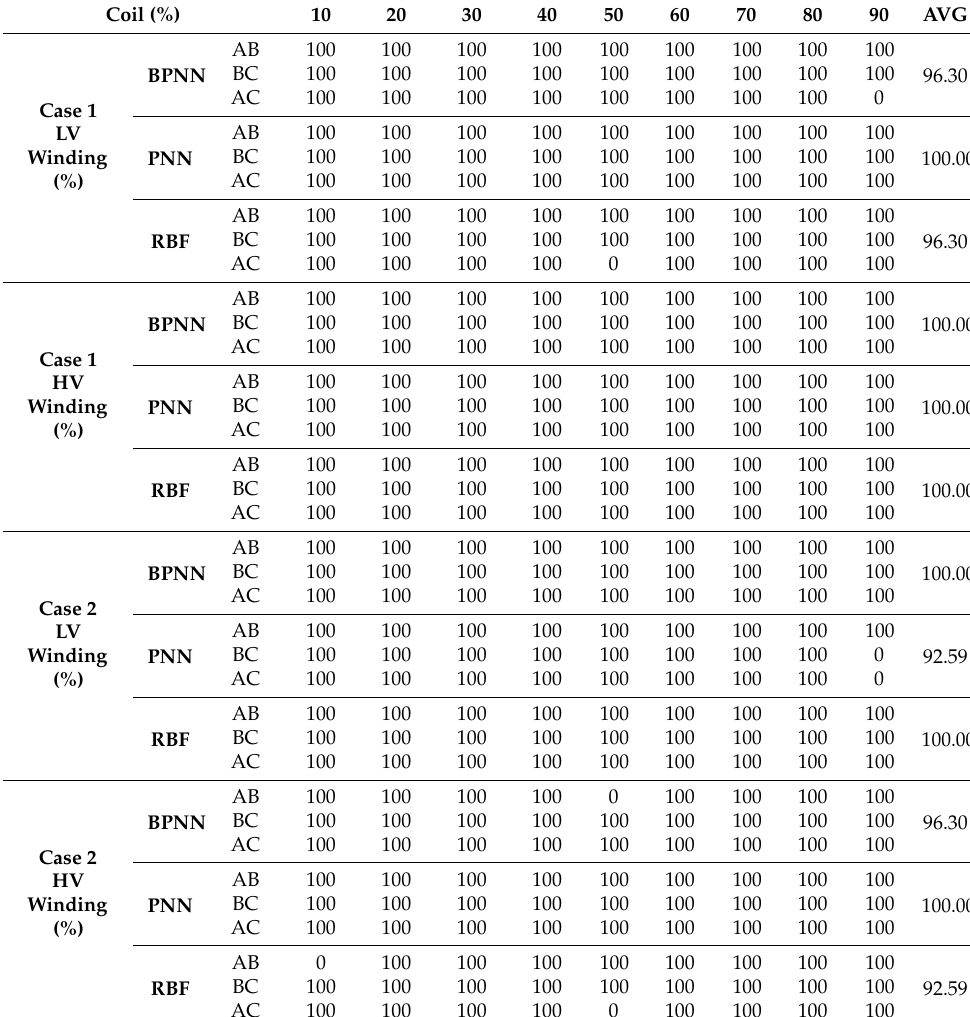
Table 4. Percentage of internal winding fault